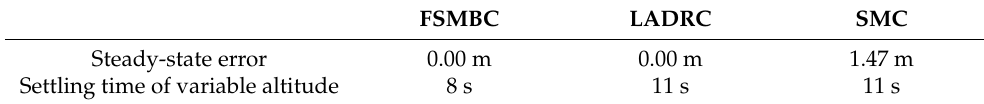
Table 3. The performance indexes of the control system for variable altitude control. FSMBC LADRC SMC Steady-state error 0.00 m 0.00 m 1.47 m Settling time of variable altitude 8 s 11